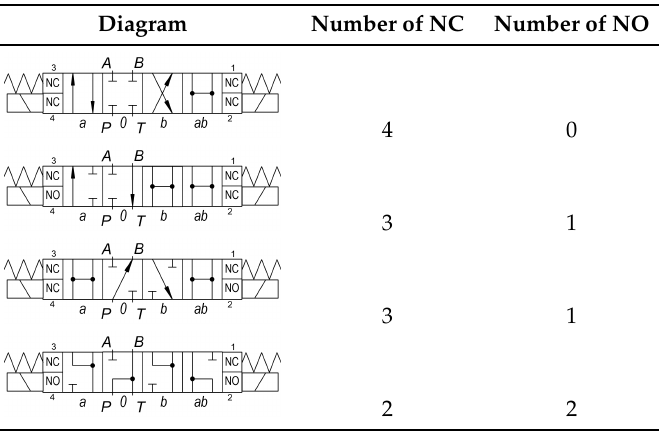
Table 1. Available seat valve